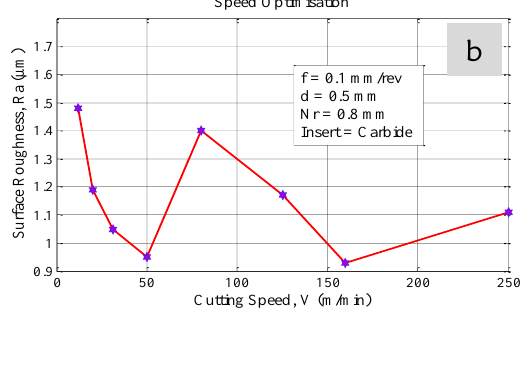
Figure 5: The trend of average surface roughness (Ra) with cutting speed (V) for constant feed rate (0.1 mm/rev), constant depth of cut (0.5 mm) and tool nose